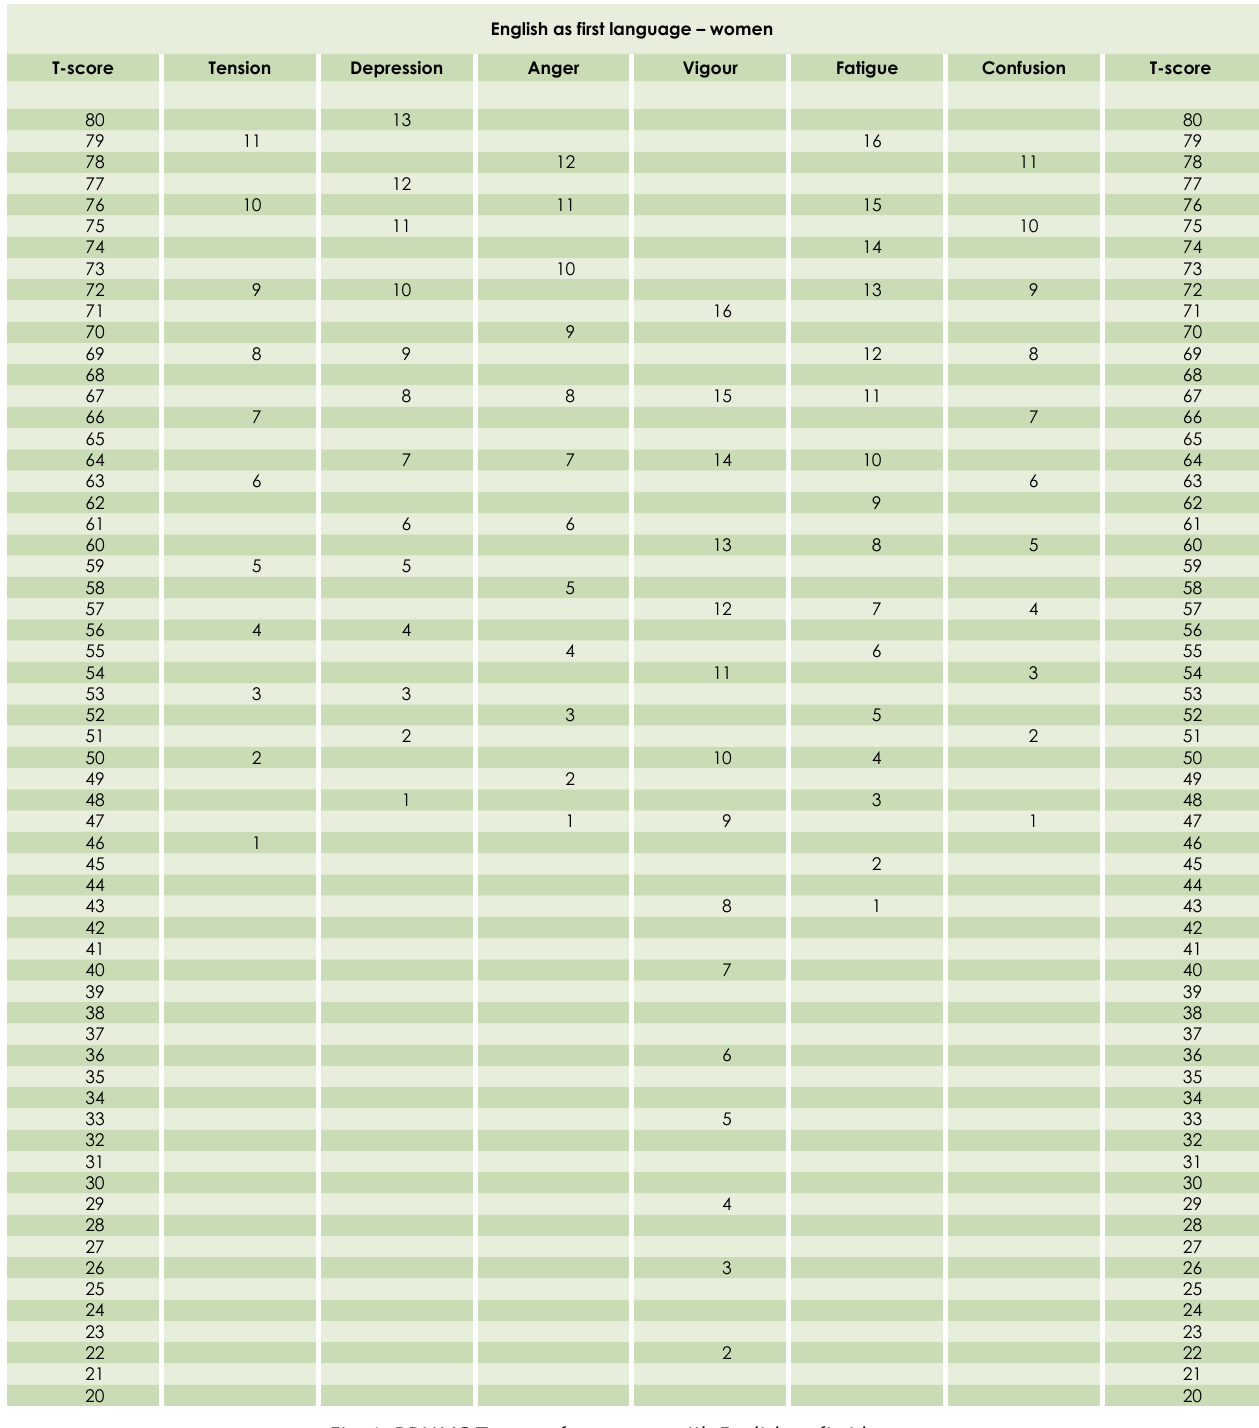
Fig. 1. BRUMS T-scores for women with English as first